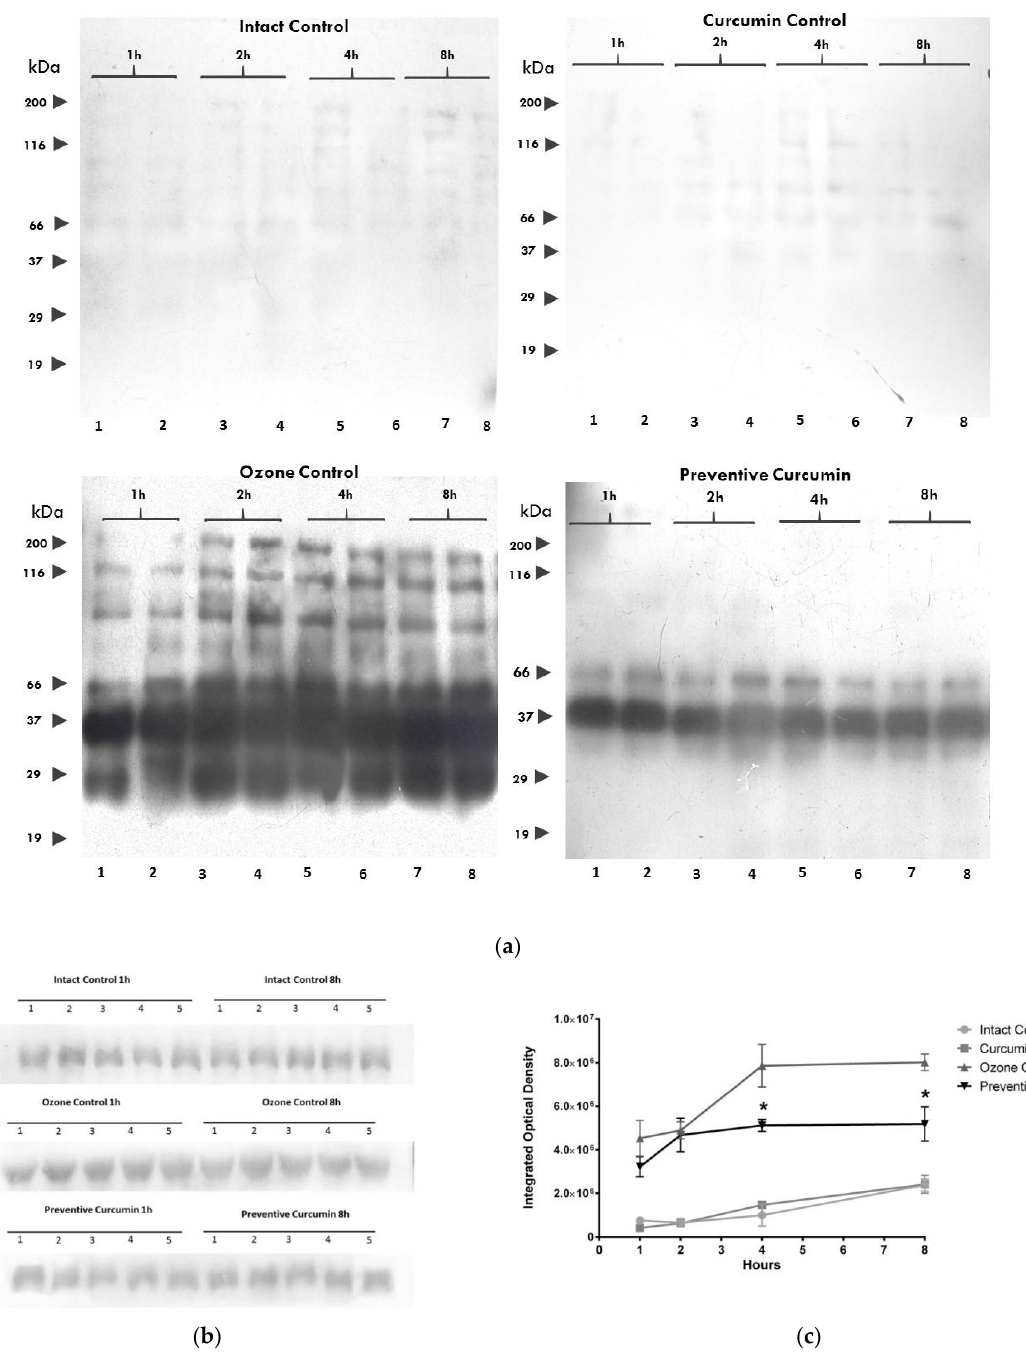
Figure 6. Effect of CUR against protein nitrosylation (Tirosin nitrosylation, 3-NT) caused by short-term ozone exposure (Table S6). ( a ) Detection of 3-NT in plasma proteins was performed by Western blot. A representative assay ( n = 2) at different ozone exposure times is shown. In each assay, the labeled lanes correspond to the 3-NT profile from two different animals in the intact control, curcumin control, ozone control, and preventive curcumin groups. The arrows on the left side indicate the location of molecular markers. ( b ) Normalization for protein concentration in loaded samples for experimental groups was with an n value of 5 for each group at the exposure times. ( c ) The graph depicts the comparison of integrated optical density (arbitrary units) mean values and SEM obtained from 3-NT plasma protein bands at different ozone exposure times in the experimental groups ( n = 5); the asterisk indicates a statistical difference between the preventive curcumin and ozone control groups ( p < 0.05) at 4 and 8 h. The intact control and curcumin control groups showed low dispersion values and cannot be visualized at the used